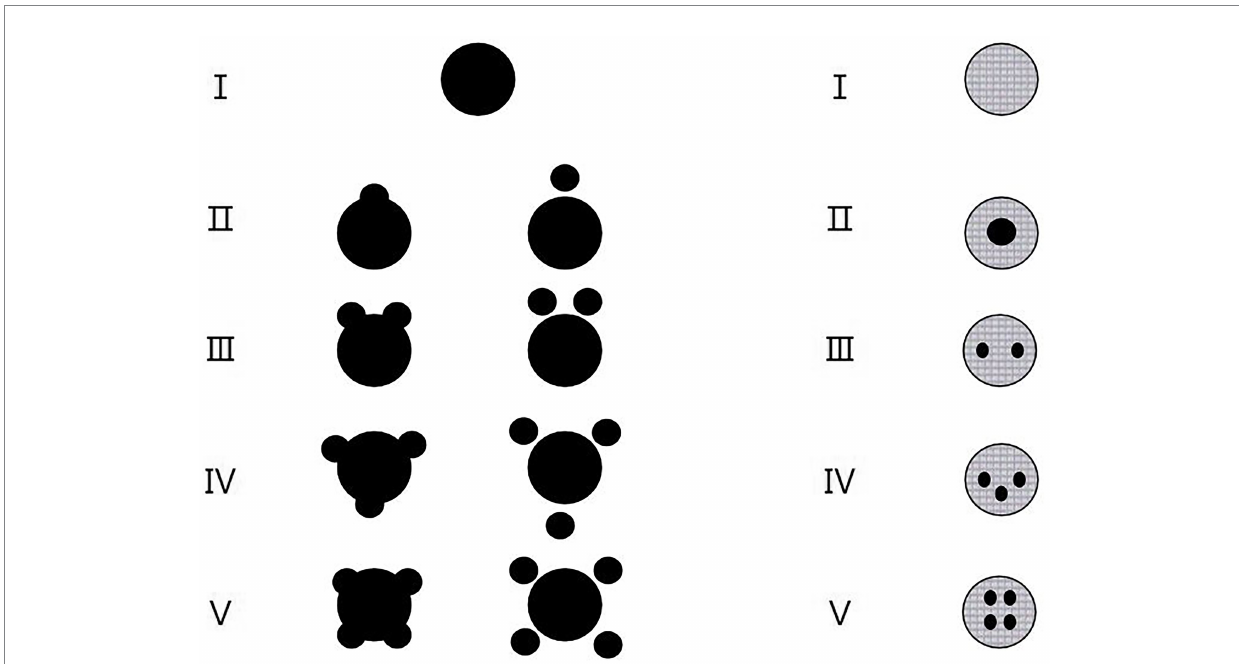
FIGURE 1 The categorical scales according to the grades of hematoma shapes (left lane) and the grades of hematoma densities (right lane). (Left lane) Classification of hematoma shapes by grade. Grade I, Only one regular (usually rounded) hematoma; Grade II, One regular hematoma plus one small hemorrhagic satellite focus; Grade III, One regular hematoma plus two small hemorrhagic satellite foci; Grade IV, One regular hematoma plus three small hemorrhagic satellite foci; Grade V, One regular hematoma plus four or more small hemorrhagic satellite foci. Regular hematoma shapes include grades of I and II while irregular hematoma shapes include grades of III to V. (Right lane) Classification of hematoma densities by grade. Grade I, Macroscopic hematoma density is consistent; Grade II, Macroscopic hematoma density are segmented to 2 places; Grade III, Macroscopic hematoma density are segmented to 3 places; Grade IV, Macroscopic hematoma density are segmented to 4 places; Grade V, Macroscopic hematoma density are segmented to 5 places or more. Homogeneous hematoma densities include grades of I and II while heterogeneous hematoma densities include grades of